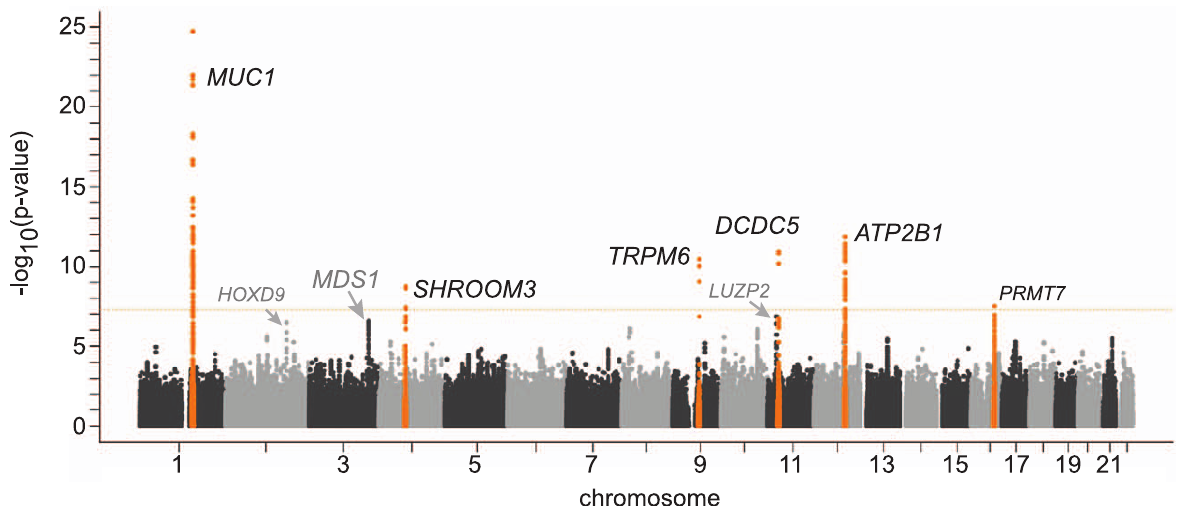
Figure 1. Genome-wide –log 10 (p-value) plot from association analyses with serum magnesium concentrations in 15,366 participants of European ancestry from the Cohorts for Heart and Aging Research in Genomic Epidemiology (CHARGE) Consortium. Adjusted for age, sex, and center. doi:10.1371/journal.pgen.1001045.g001 S2E, S2F. Results were similar when individuals on hypertension medications were excluded from the discovery analysis.